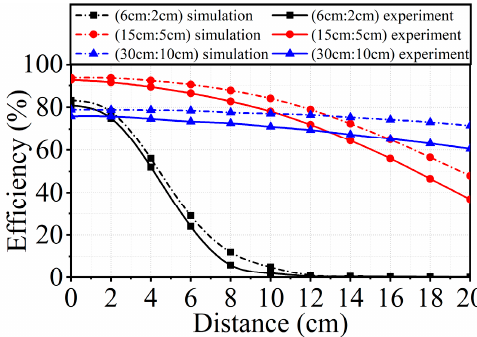
Figure 17. PTE curves with different coil radii.